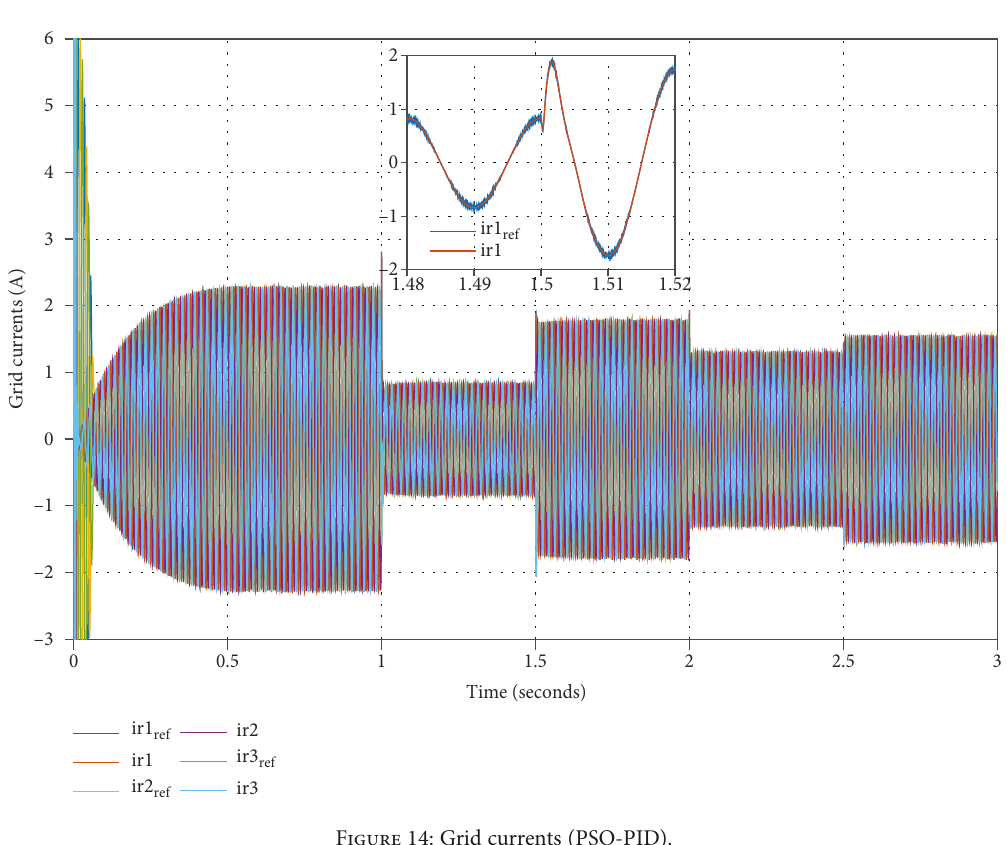
Figure 14: Grid currents